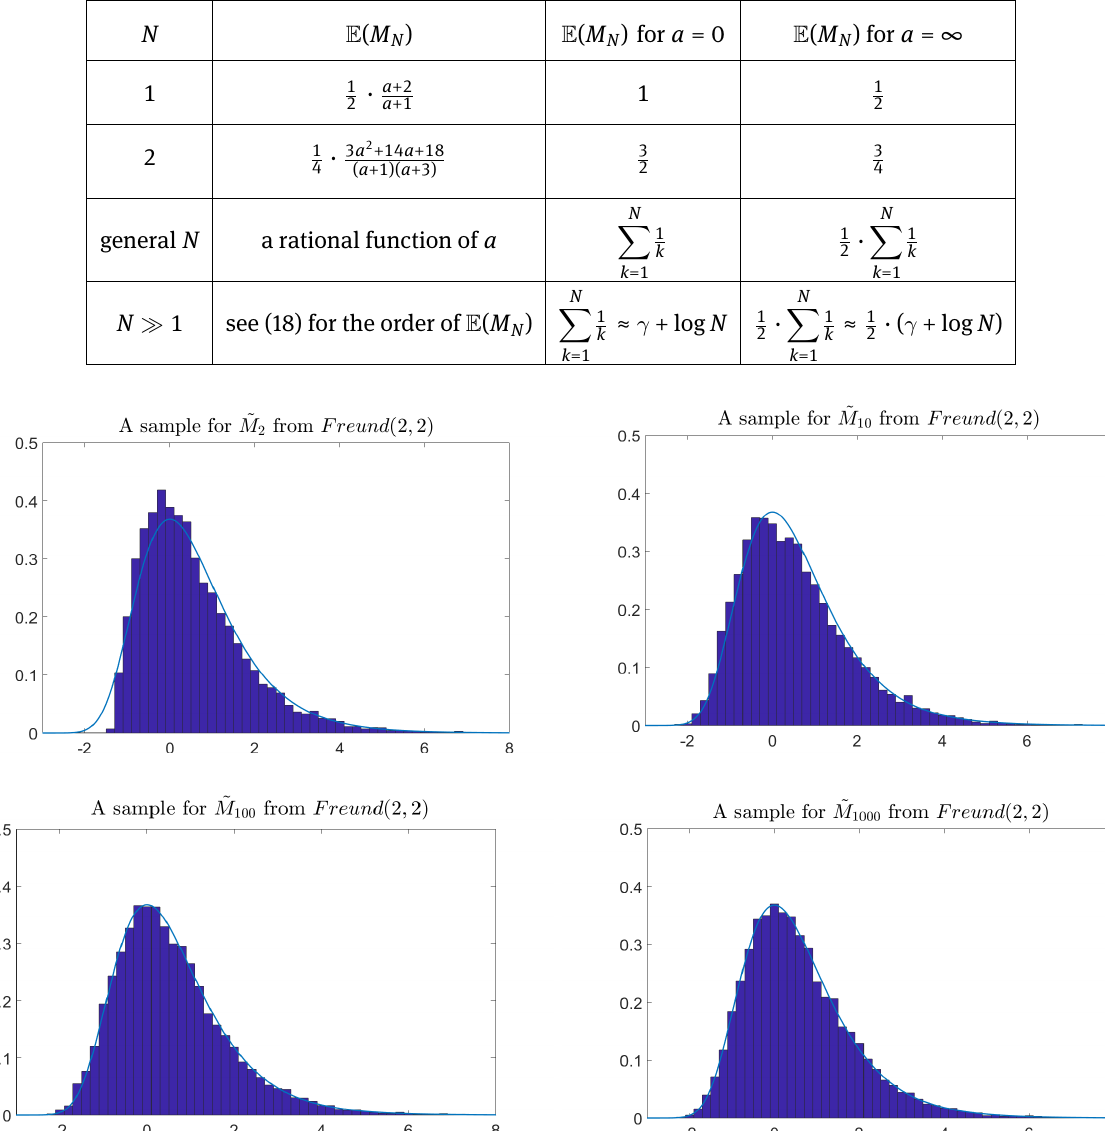
Table 1: Expectation of the componentwise maximum in N independent copies of Freund( a , 2) .